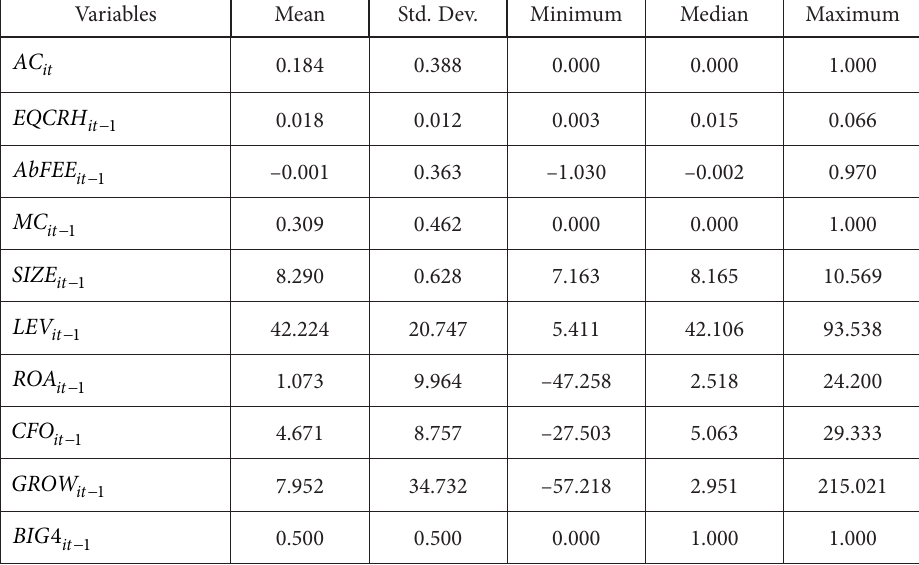
Table 2. Descriptive statistics (N =